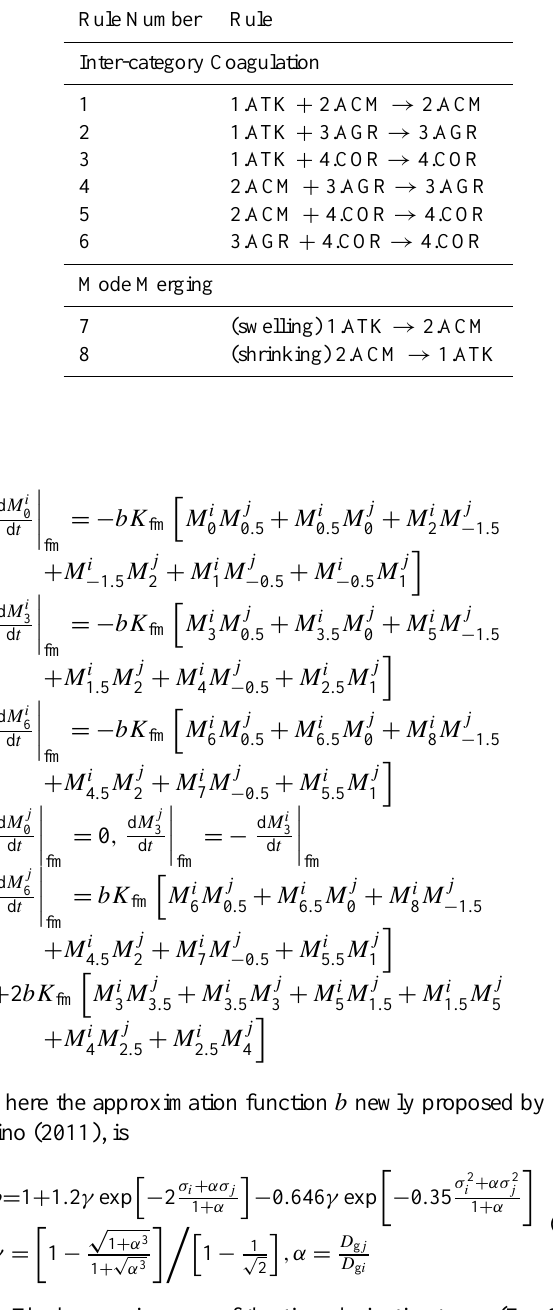
Table 3. Rules for transfer of the three moments and chemical mass concentrations from one category to another due to inter-category coagulation and mode